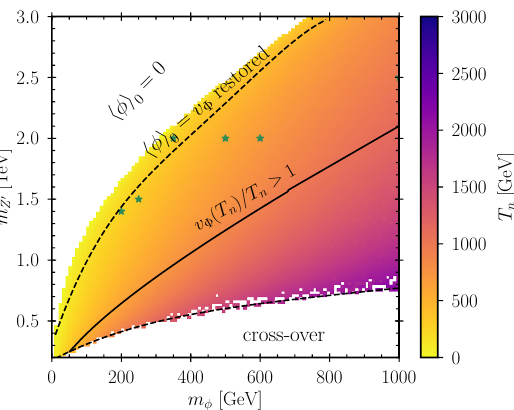
Figure 18 . Same as (cid:12)gure 17, but at each parameter point the DM mass is set to a value that yields the correct relic abundance. The masses of e 4 , e 5 , and (cid:23) 4 are set to m HL = 1 : 5 minimum at (cid:30) = v (cid:8) for high m